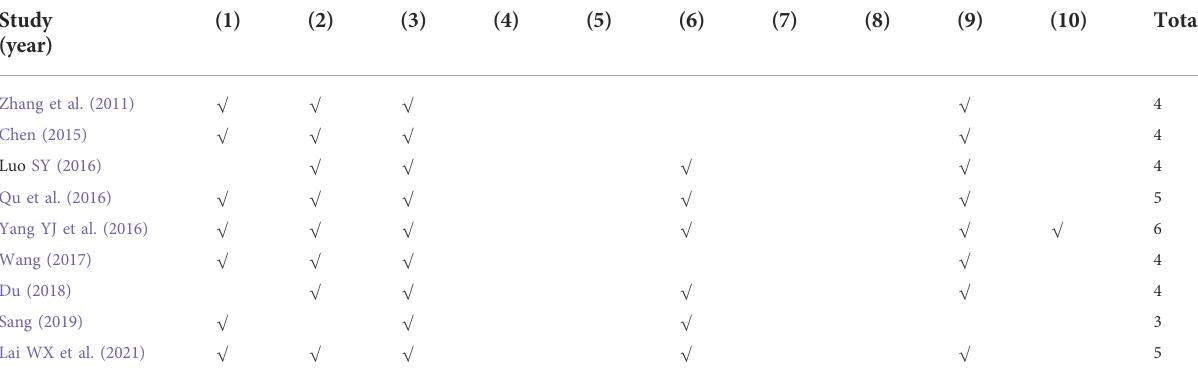
TABLE 2 Risk of bias of the included studies.